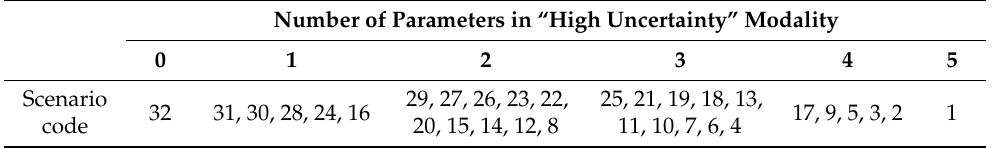
Table 3. The number of parameters in the “High uncertainty” modality per